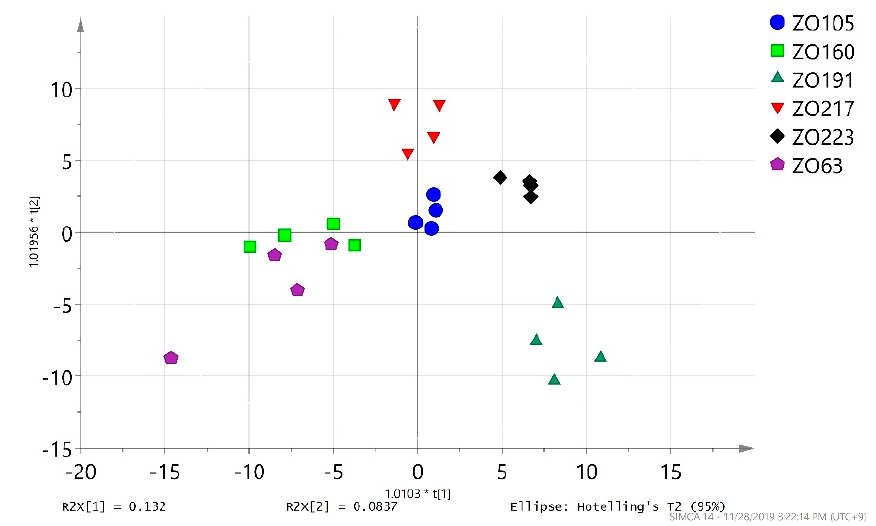
Figure 2. The scatter plot of the orthogonal partial least squares projection to latent structures di ff erential analysis (OPLS-DA) scores generated from the gas chromatography combined with time-of-flight-mass spectrometry (GC-TOF-MS) data ( n = 24) on Z. barbatum accessions. The first two principle components of the principal component analysis (PCA) accounted for a total of 22% of the